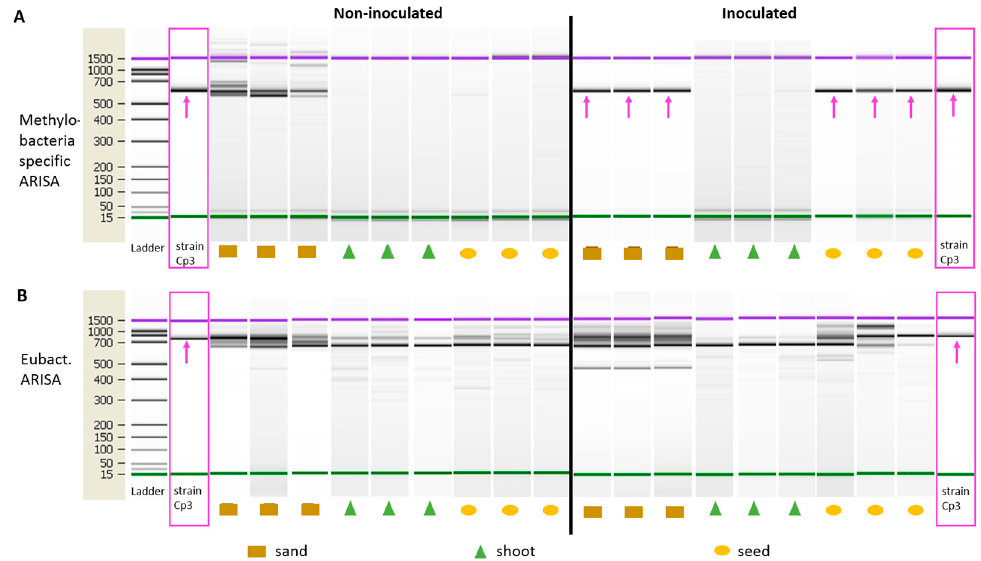
Figure 2. Methylobacteria specific ARISA fingerprints and general bacteria Automated Ribosomal Intergenic Spacer Analysis (ARISA) fingerprints of the control non-inoculated A. thaliana plants and plants inoculated with Methylobacterium sp. Cp3. Pink boxes indicate the fingerprint of the inoculated strain Cp3 and the arrows point to the specific amplicon for Cp3.